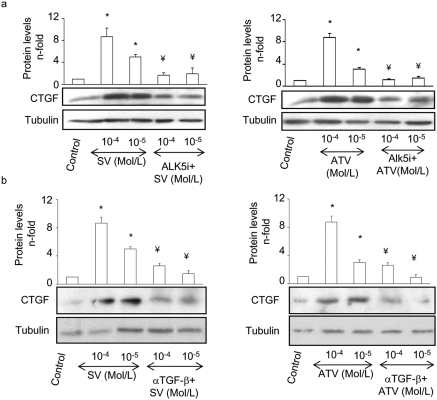
Endogenous TGF-β is involved in Statin-induced CTGF expression.Serum starved VSMCs were preincubated for 72h with highest concentrations of statins a. Some cells were preincubated for 1 h with 10−5 mol/L of ALK5i (a) or 10 µg/mL of TGF-β neutralizing antibody (α-TGF-β) (b). Figure shows a representative western blot in the lower panel and in the upper panel the mean±SEM of 4 experiments. *p<0.05 vs. control. ¥ p<0.05 vs. SV 10−4 Mol/L.